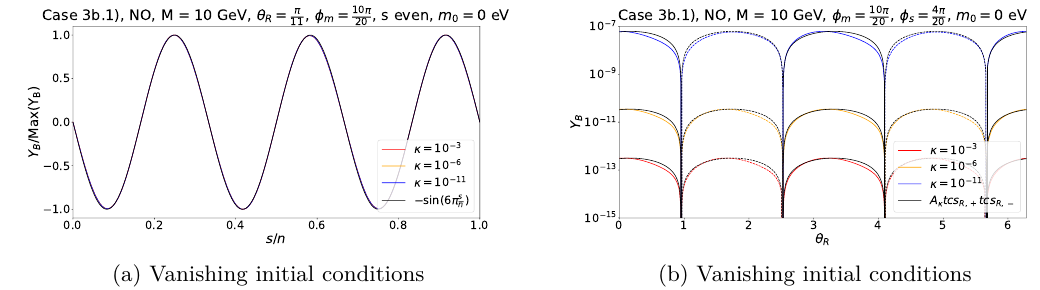
, treated as continuous parameter. Figure 21 . Case 3 b.1) The left plot displays Y B as function of s n We assume that s is even. The Majorana mass M is fixed to M = 10 GeV, the angle θ has the R value θ = π and three different values of κ are used, κ ∈ { 10 − 3 , 10 − 6 , 10 − 11 } . The group theory R 11 parameters n and m are chosen as in figure 20. Light neutrino masses have strong NO. The right plot displays Y as function of the angle θ . The same values for M , κ , n and m as well as the B R same light neutrino mass spectrum as in plot (a) of this figure are used. The parameter s is fixed to (cid:3) Max (cid:2) | Y B | . The coefficient A is given by , where tcs and tcs s = 4 and thus φ s = 4 π (cid:3) κ R, + R, − Max (cid:2) 20 tcs R, + tcs R, − are defined in eq. (6.38), for each κ . Both negative (dashed lines) as well as positive (continuous lines) values of the BAU are